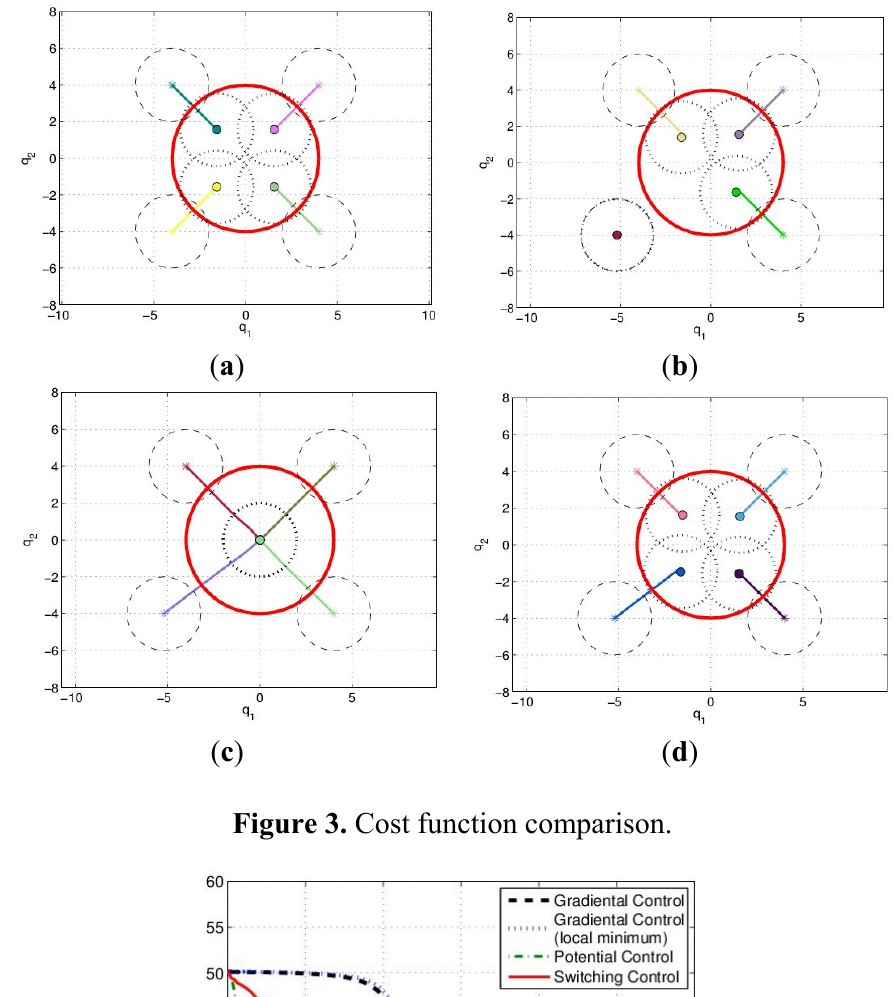
Figure 2. ( a ) Gradient controller performance. ( b ) Gradient controller with a local minimum. ( c ) Potential field controller performance. ( d ) Complete controller performance.